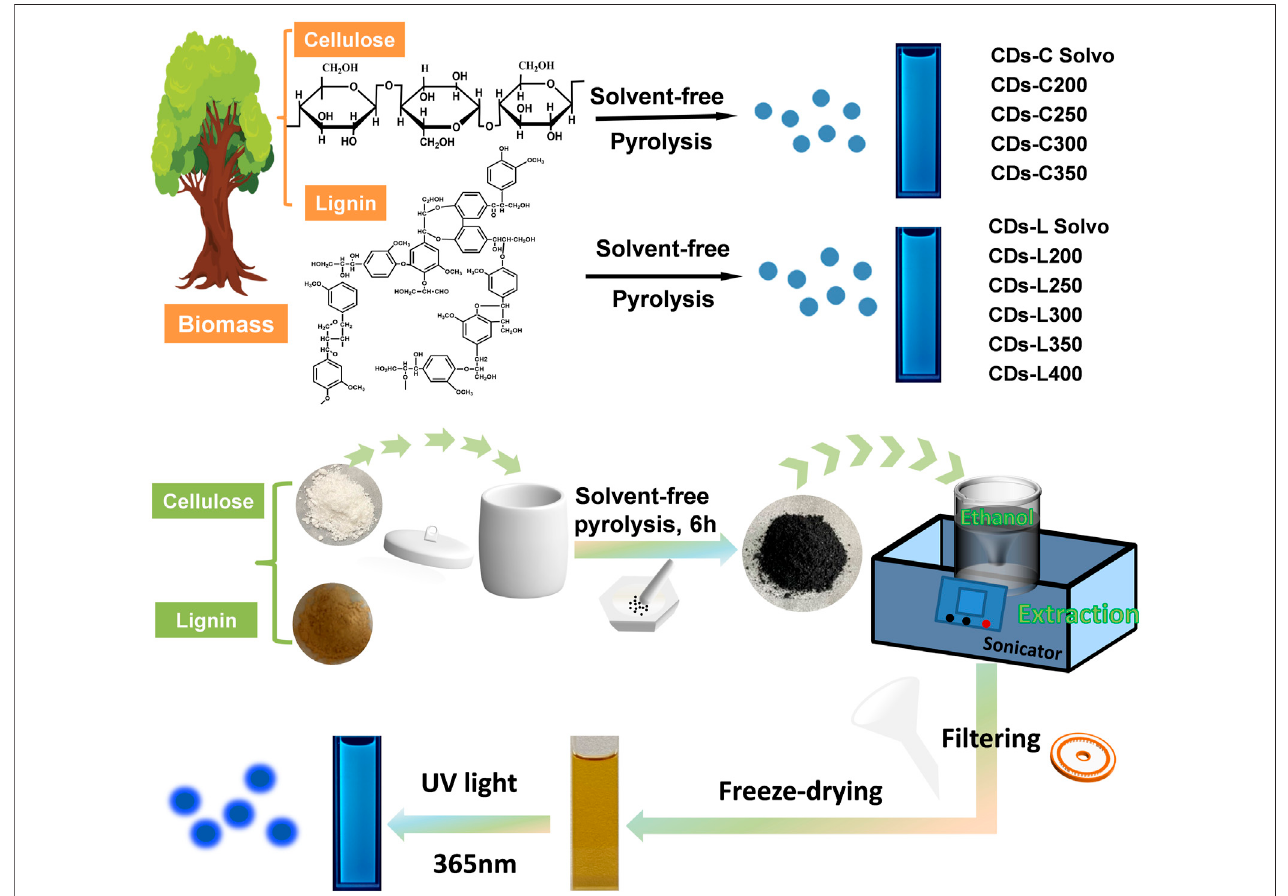
FIGURE 1 | The synthesis route of cellulose- and lignin-based CDs by solvent-free pyrolysis.